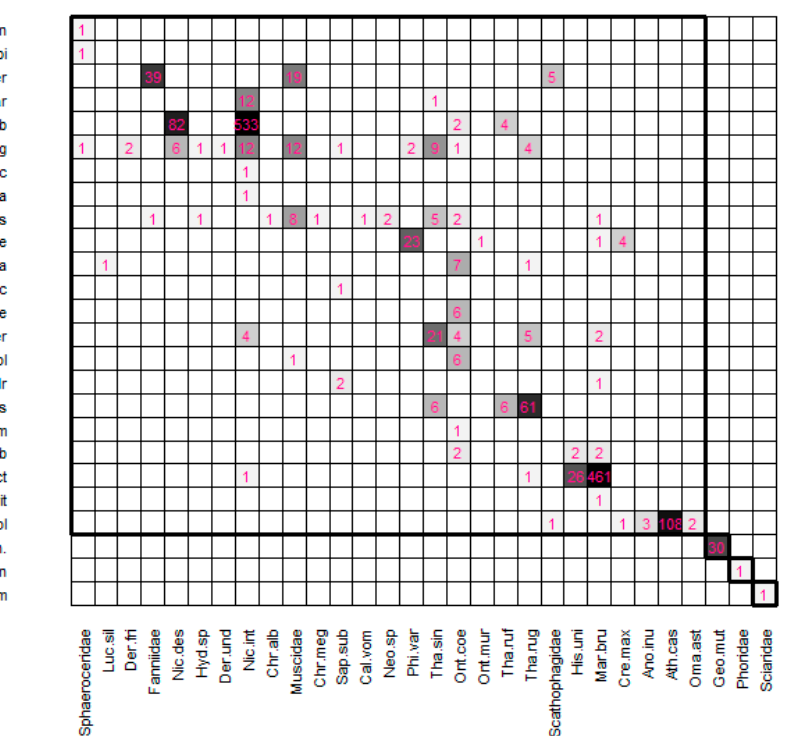
Figure 2. Interaction matrix between mite species (rows) and host insect families/species (columns). The intensity of the color of the grid is directly proportional to the number of interactions (purple number inside the square). The abbreviations used are the same as in Figure 1.